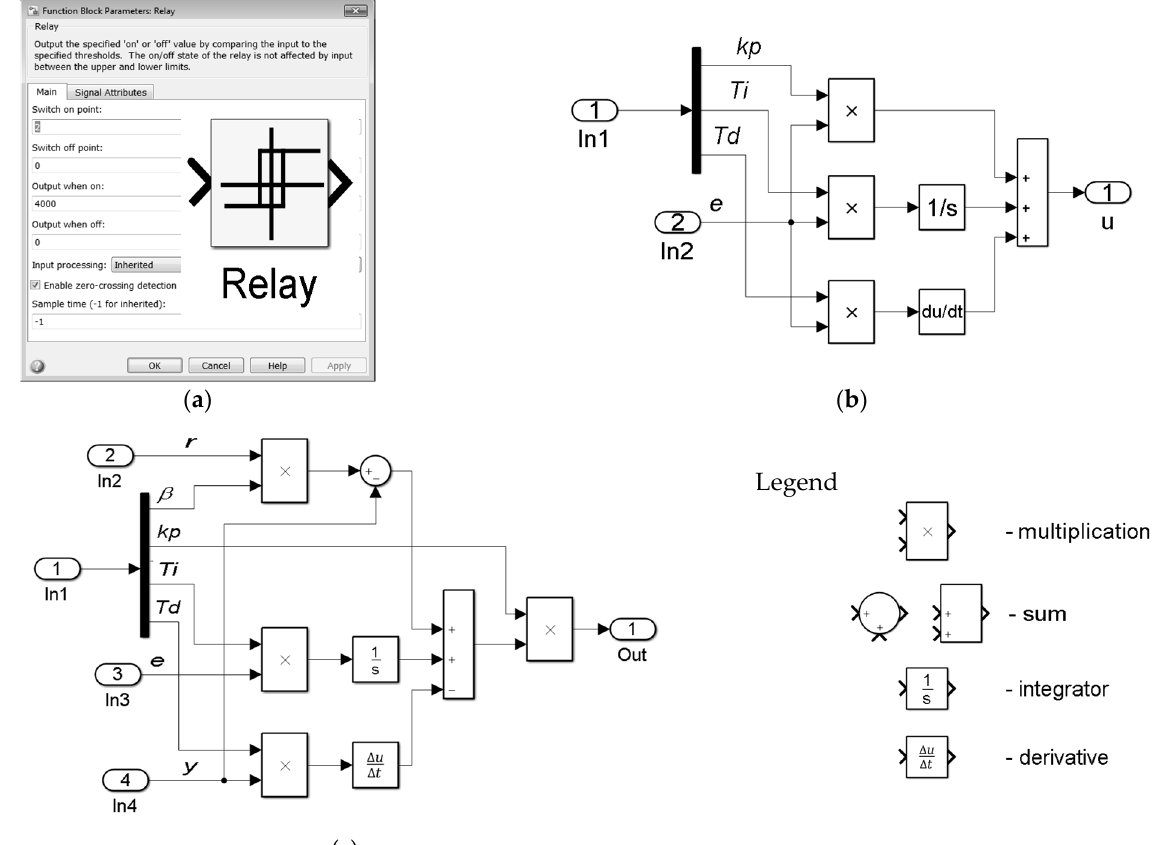
Figure 5. Controller block scheme: ( a ) relay, ( b ) PID and ( c ) I-PD.